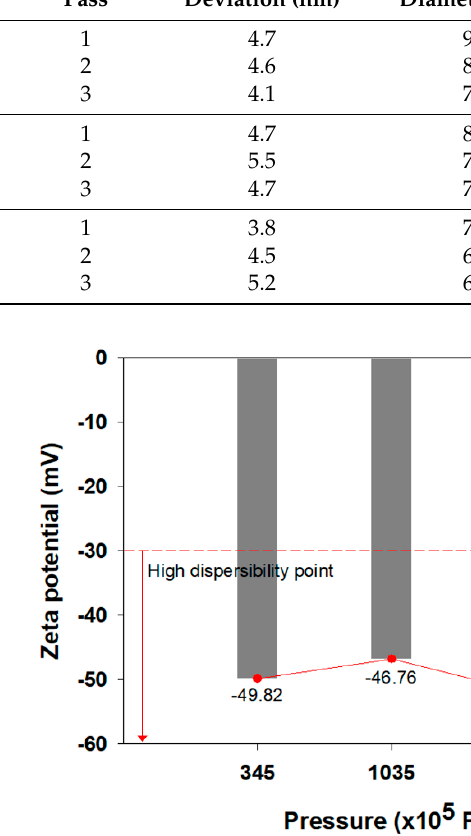
Figure 9. Zeta potentials of samples subjected to high-pressure dispersion.